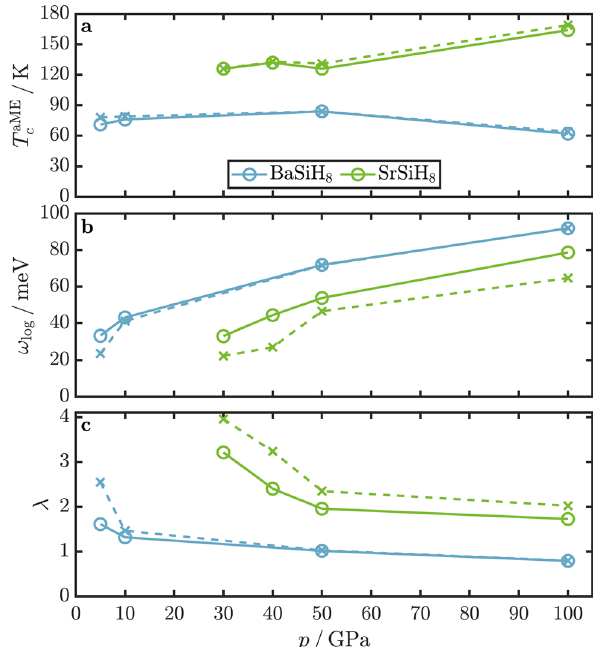
Fig. 5 Superconducting properties as a function of pressure. a T c from anisotropic ME theory, b ω log , and c λ (bottom panel) as functions of pressure for BaSiH 8 (blue) and SrSiH 8 (green). Circles and solid lines (crosses and dashed lines) indicate anharmonically corrected (harmonic) calculations. The contributions to α 2 F ( ω ) from the E g mode at X are set to zero in the harmonic calculations for SrSiH 8 at 30 and 40 GPa, as the corresponding phonon frequencies are